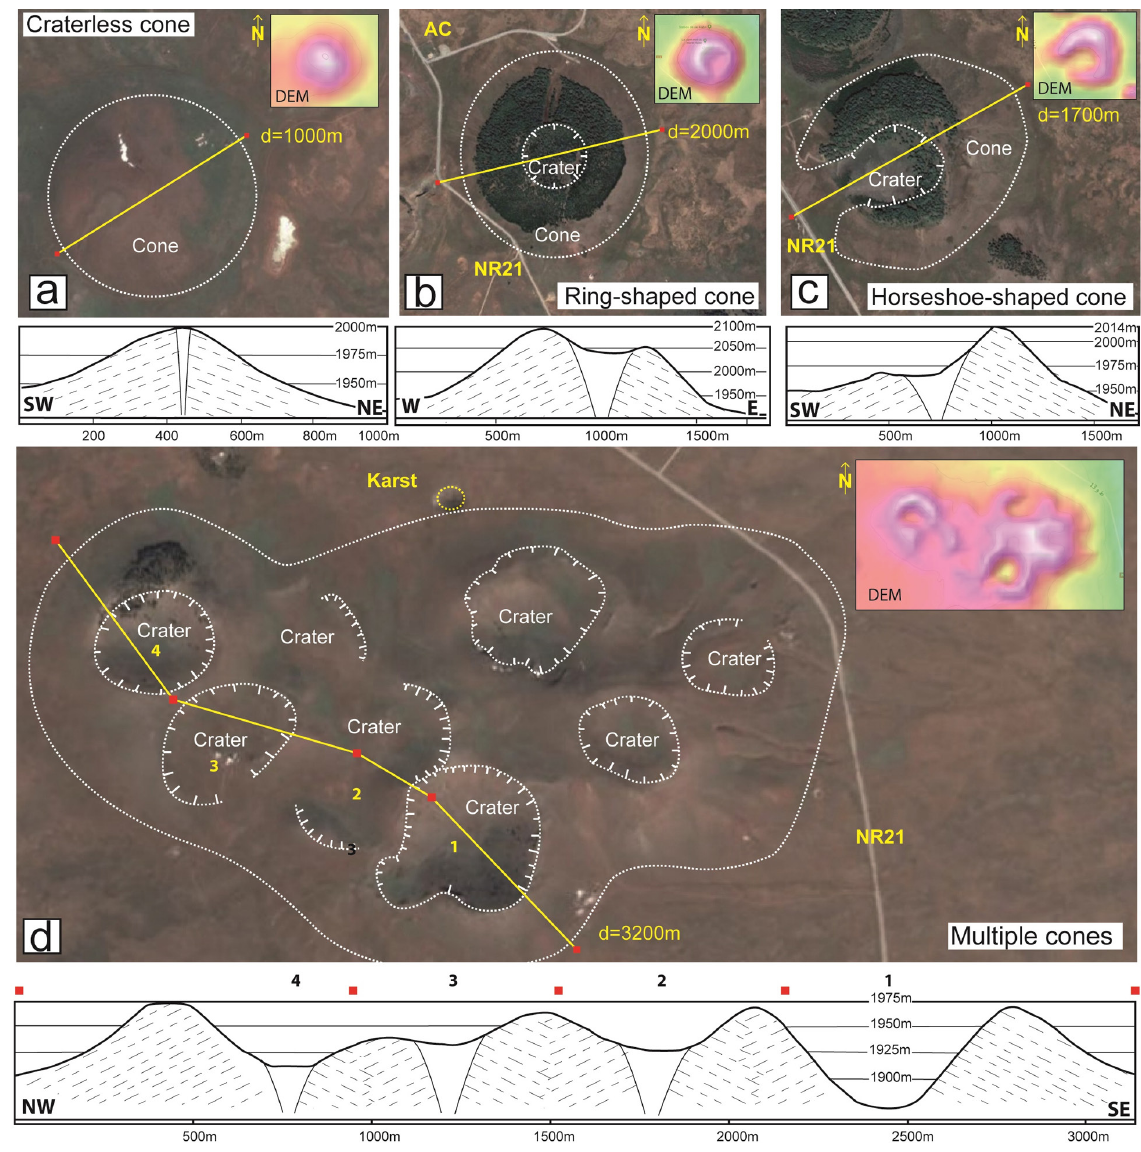
Fig. 4. Morphology, shape, and crater outlines of cones sketched on Google satellite images jointed to the digital elevation overview and the cross-section sketch. DEM – Digital Elevation Model; NR21 – national roadway no.